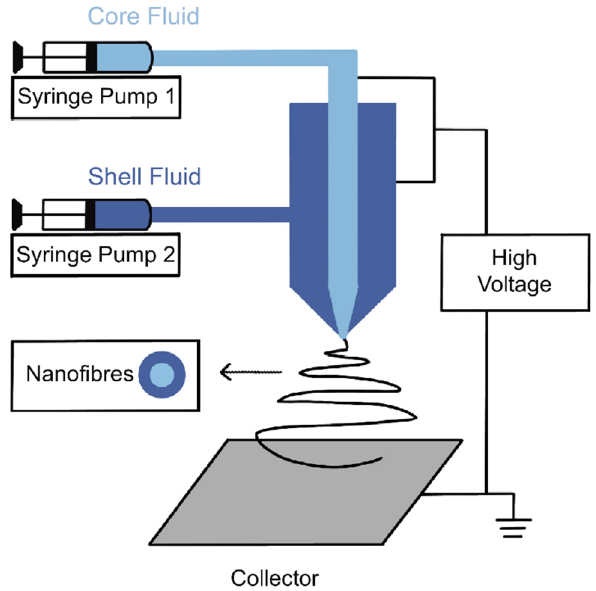
Figure 1. Schematic diagram of a coaxial electrospinning setup.